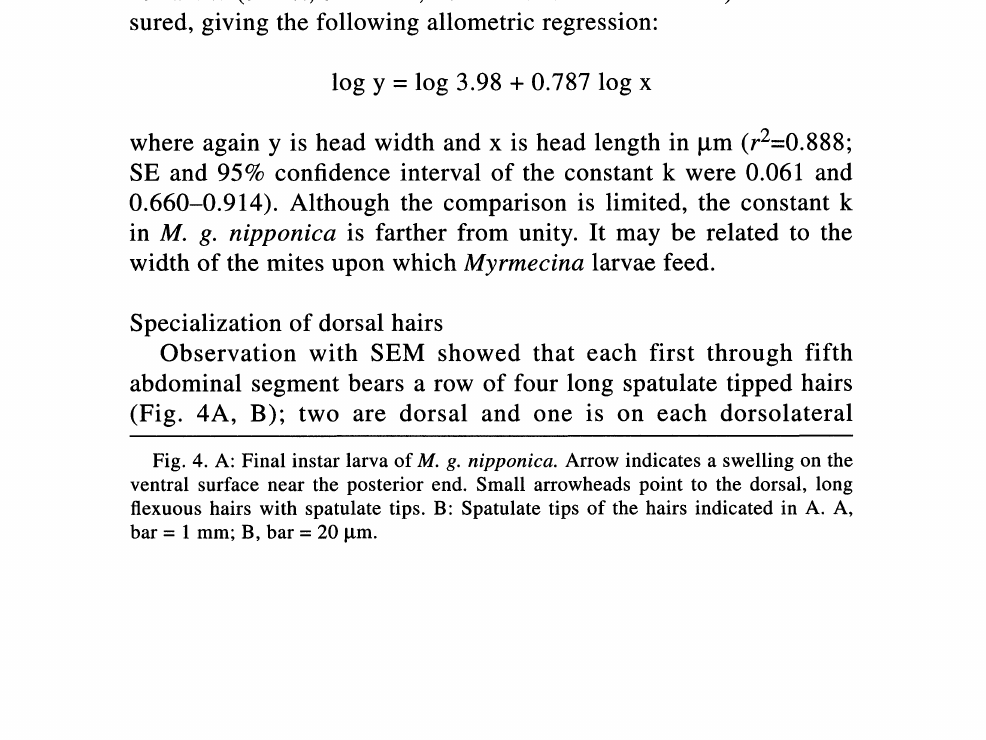
Fig. 4. A: Final instar larva of M. g. nipponica. Arrow indicates a swelling on the ventral surface near the posterior end. Small arrowheads point to the dorsal, long flexuous hairs with spatulate tips. B: Spatulate tips of the hairs indicated in A. A, bar mm; B, bar 20